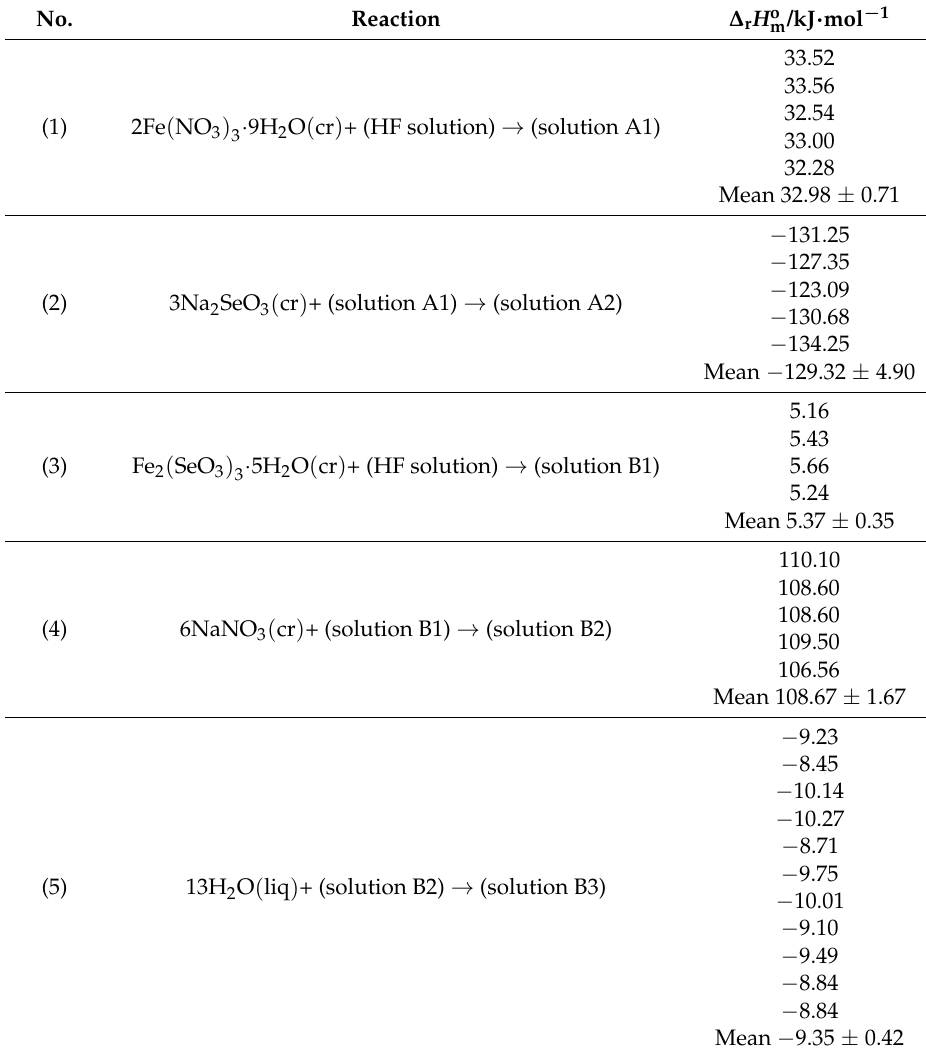
Table 3. Enthalpy of solution values for reactions (1) to (5) at T = 298 K and p = 0.1 MPa a .